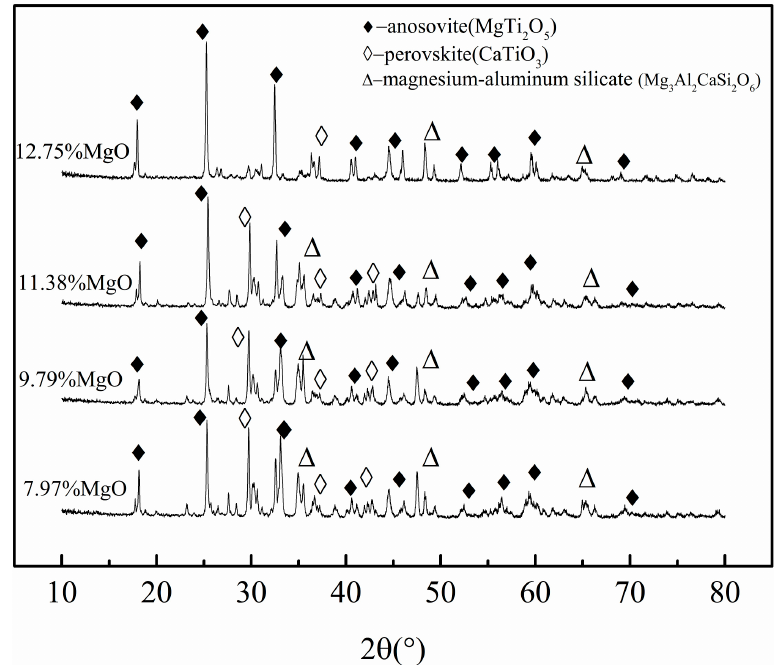
Figure 13. XRD patterns of titanium slag with varying MgO content.